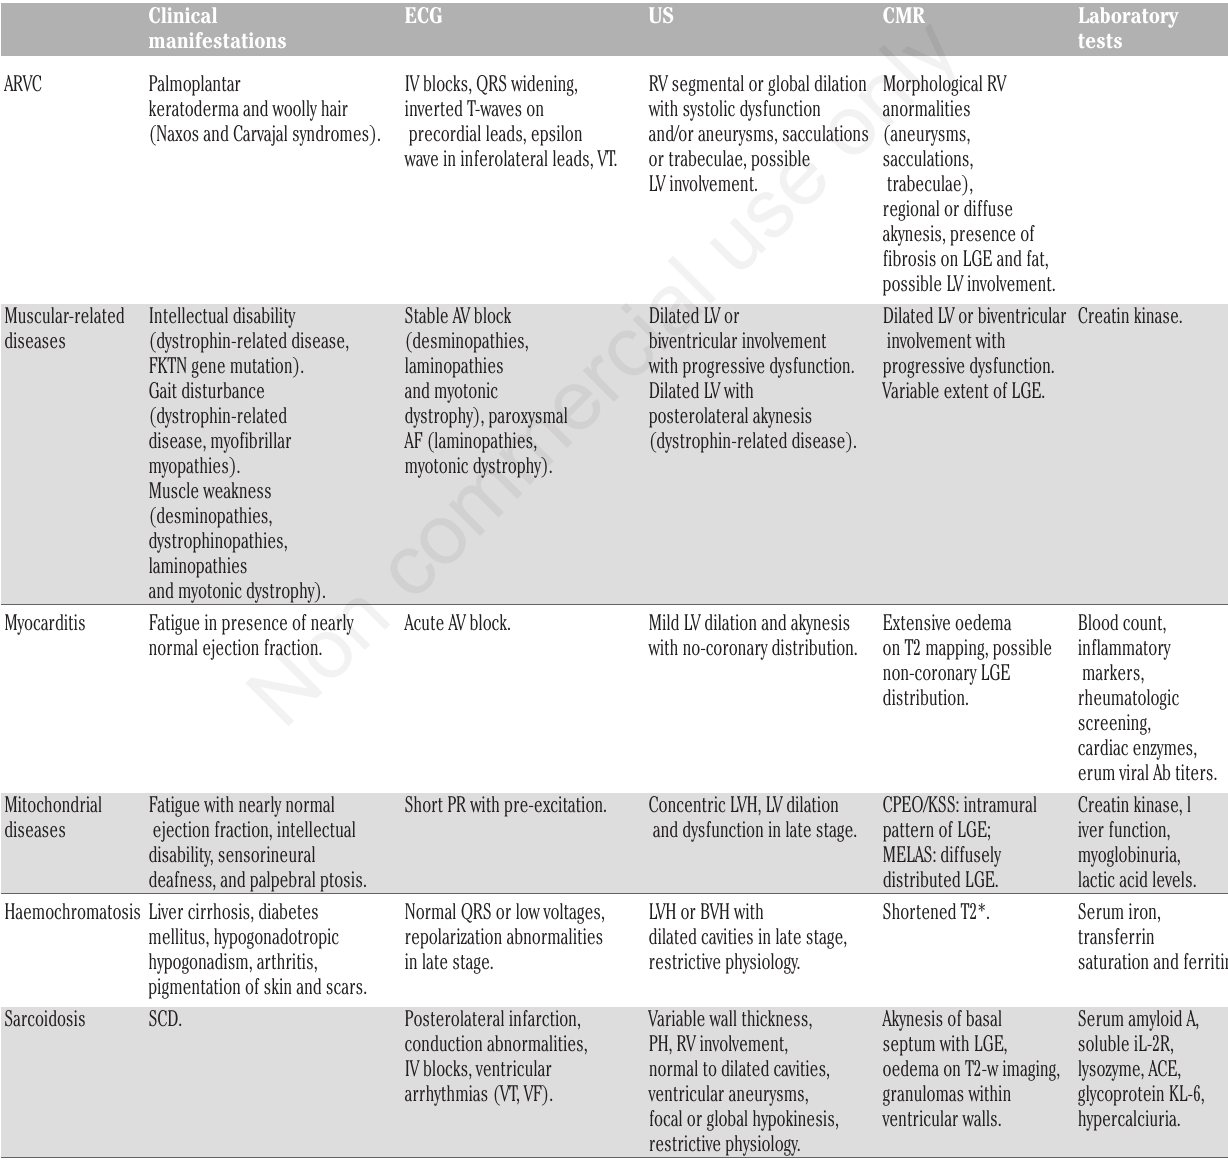
Table 2. Diagnostic clues fostering the suspicion of specific causes of dilated and right ventricular